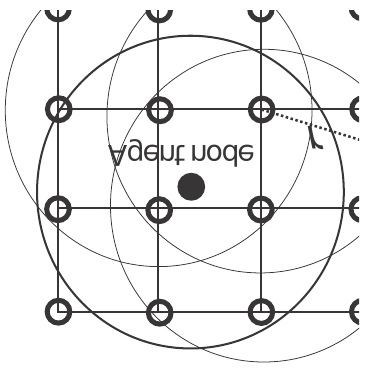
Figure 1. The exampled grid network